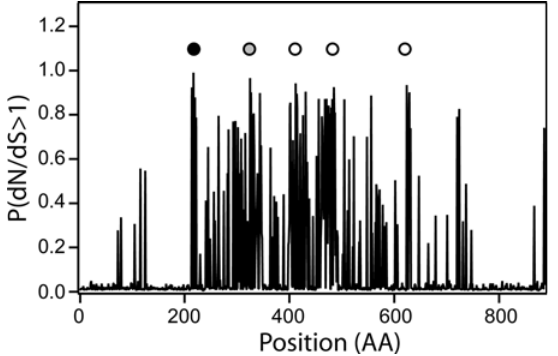
Figure 2. Positive selection on rrgA . Probability P( d N /d S . 1) that a codon is under positive selection in rrgA . The dark circle marks a site for which both test I and test II indicate positive selection with probability greater than 99%; the light gray circle marks a site for which test I and test II indicate positive selection with a probability exceeding 95%; empty circles indicate sites under positive selection with probability exceeding 95% only according to test II. doi:10.1371/journal.pone.0003660.g002 PLoS ONE |